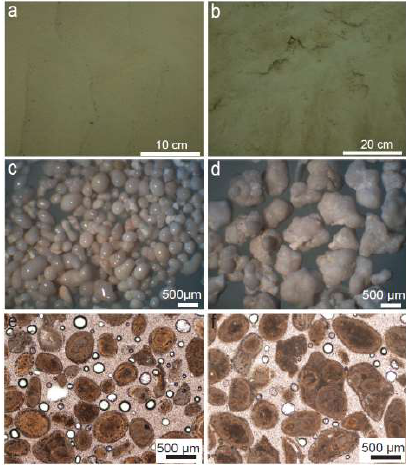
Figure 3. Photographs of the seafloor in Pigeon Cay and photomicrographs of ooids and grapestones. ( a ) Photograph of barren ripples at a distance of 20 m from the shore. ( b ) Photograph of microbially covered and encrusted ripples at a distance of 150 m from the shore. ( c – f ) Photomicrographs of grains from different locations along the transect: rounded polished ooids sampled 20 m from the shore ( c , e ), irregular dull grapestones collected 150 m from the shore ( d , f ).